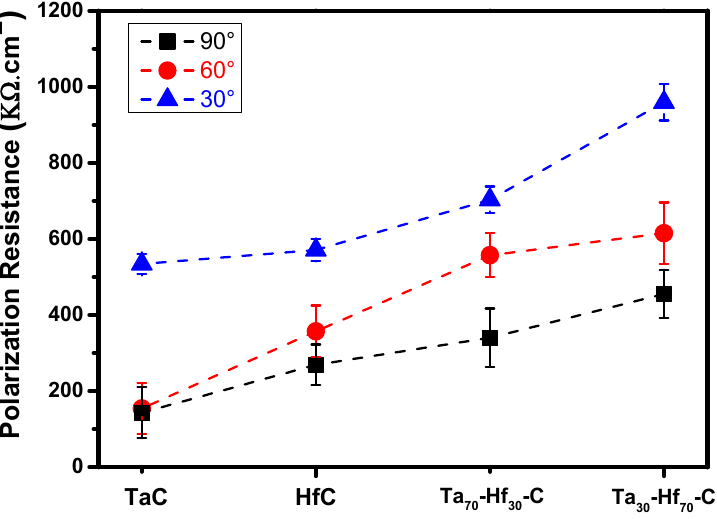
Figure 12. Polarization resistance as a function of the impact angle of the abrasive particles.